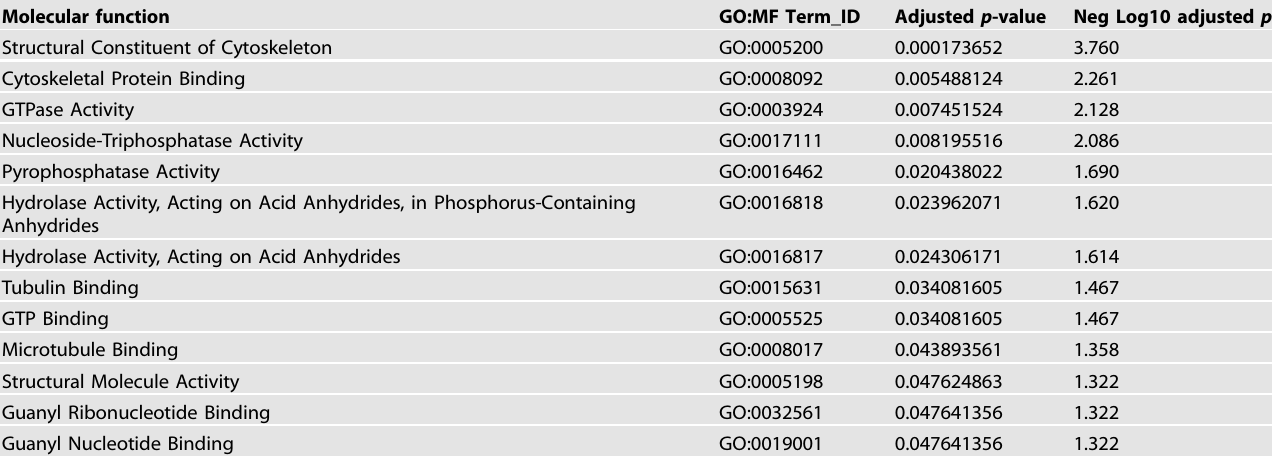
Table 5. Down-regulated GO molecular functions in Scz organoids ( p < 0.05).